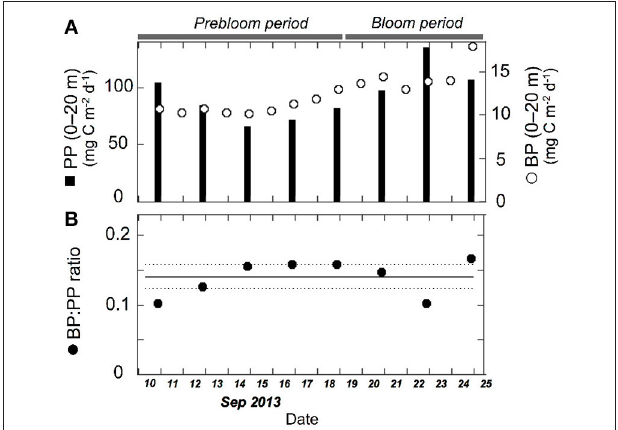
FIGURE 7 | Temporal variation in (A) depth-integrated (0–20m) bacterial production (open circles), primary production (filled bars), and (B) bacterial production:primary production ratio (BP:PP ratio). Solid and dashed lines indicate mean (0.14) and 95% confidence intervals ( ± 0.02), respectively. Primary production data are from Nishino et al. (2015) and are also available from the JAMSTEC online database (see text for details). Daily bacterial production was calculated from the time-integration of multiple data obtained in a specific time interval.